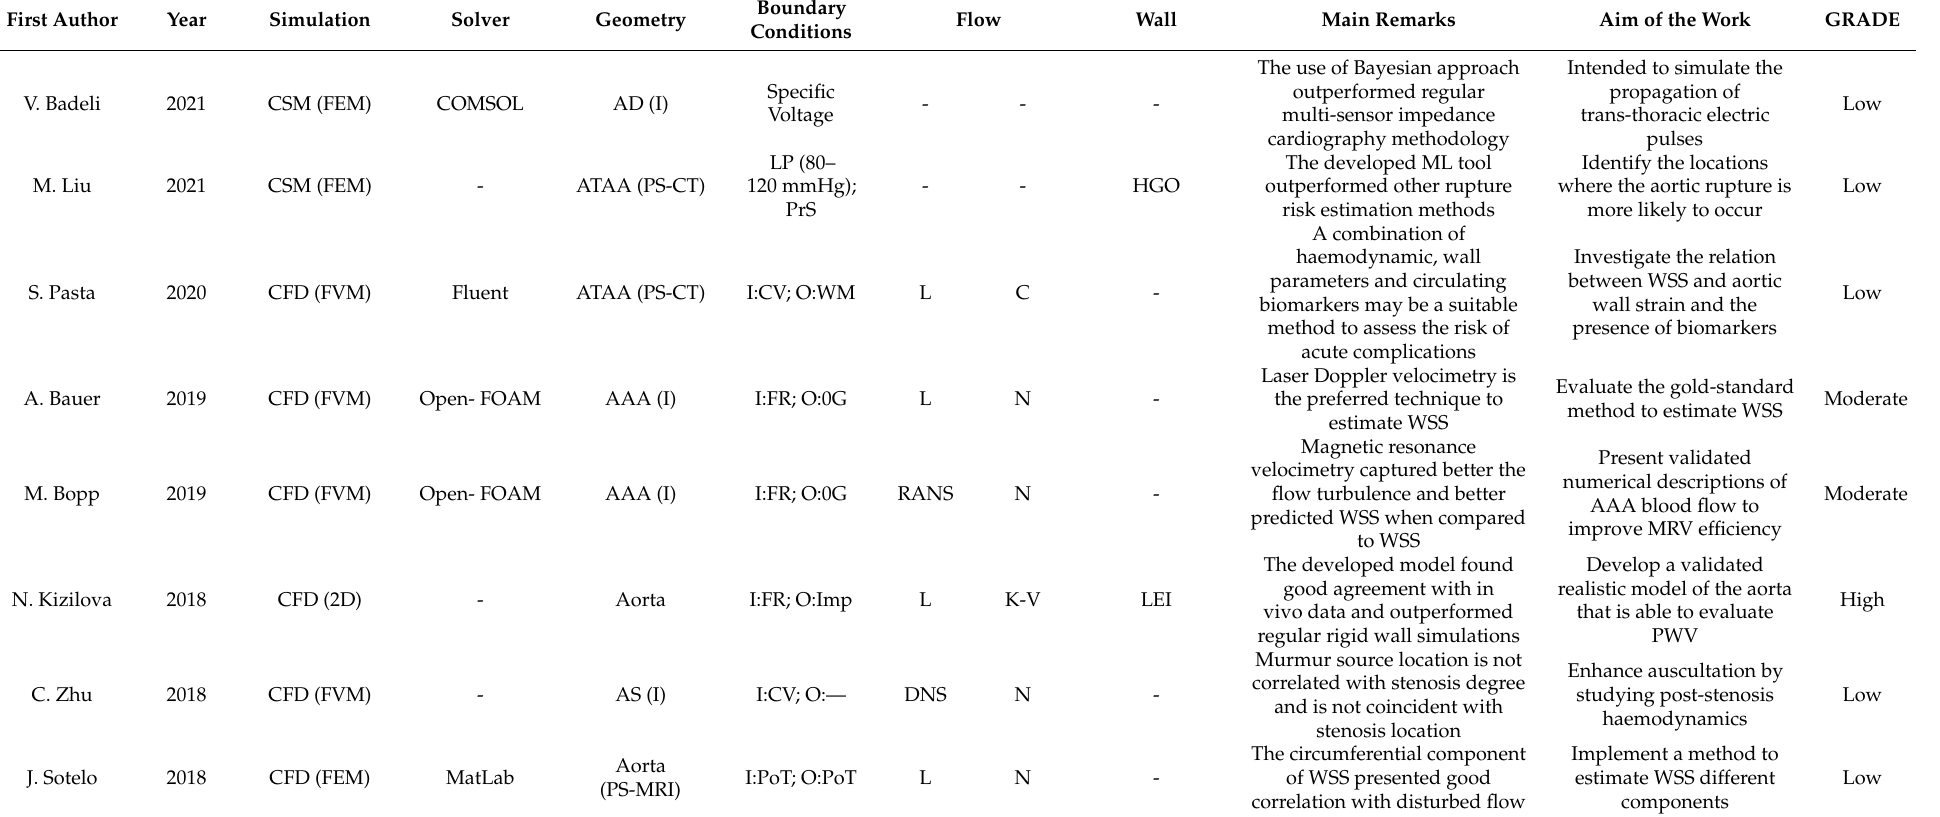
Table 4. Works regarding improvements or development of diagnosis metrics or techniques ( n = 16